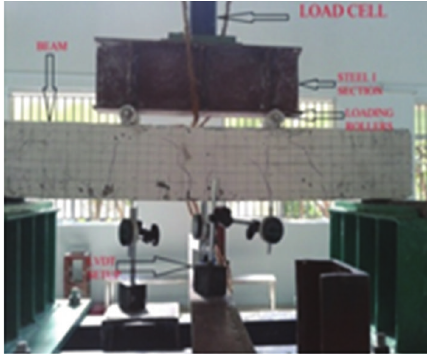
Figure 7: Flexural strength on beam.